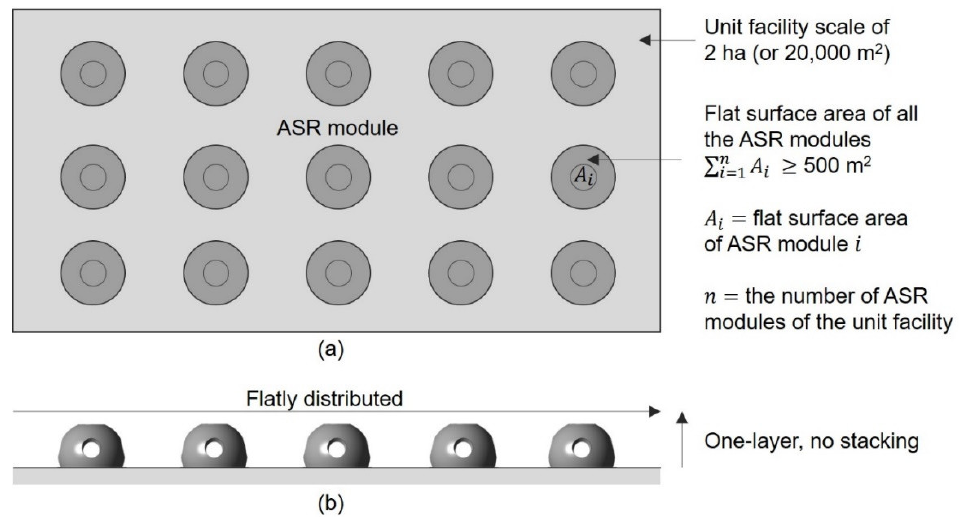
Figure 4. Representative practice of ASRs in South Korea: ( a ) plan view characterizing unit facility scale of 2 ha (or 20,000 m 2 ) and flat surface area of all the ASR modules ( ≥ 500 m 2 ) and ( b ) side view indicating the flatly distributed placement model.